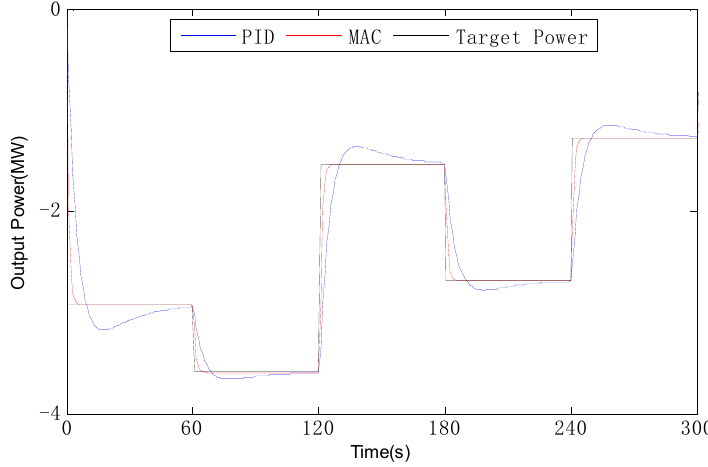
Figure 15. The power control curves of a hybrid energy storage system based on PID control and MAC control in the period of 300